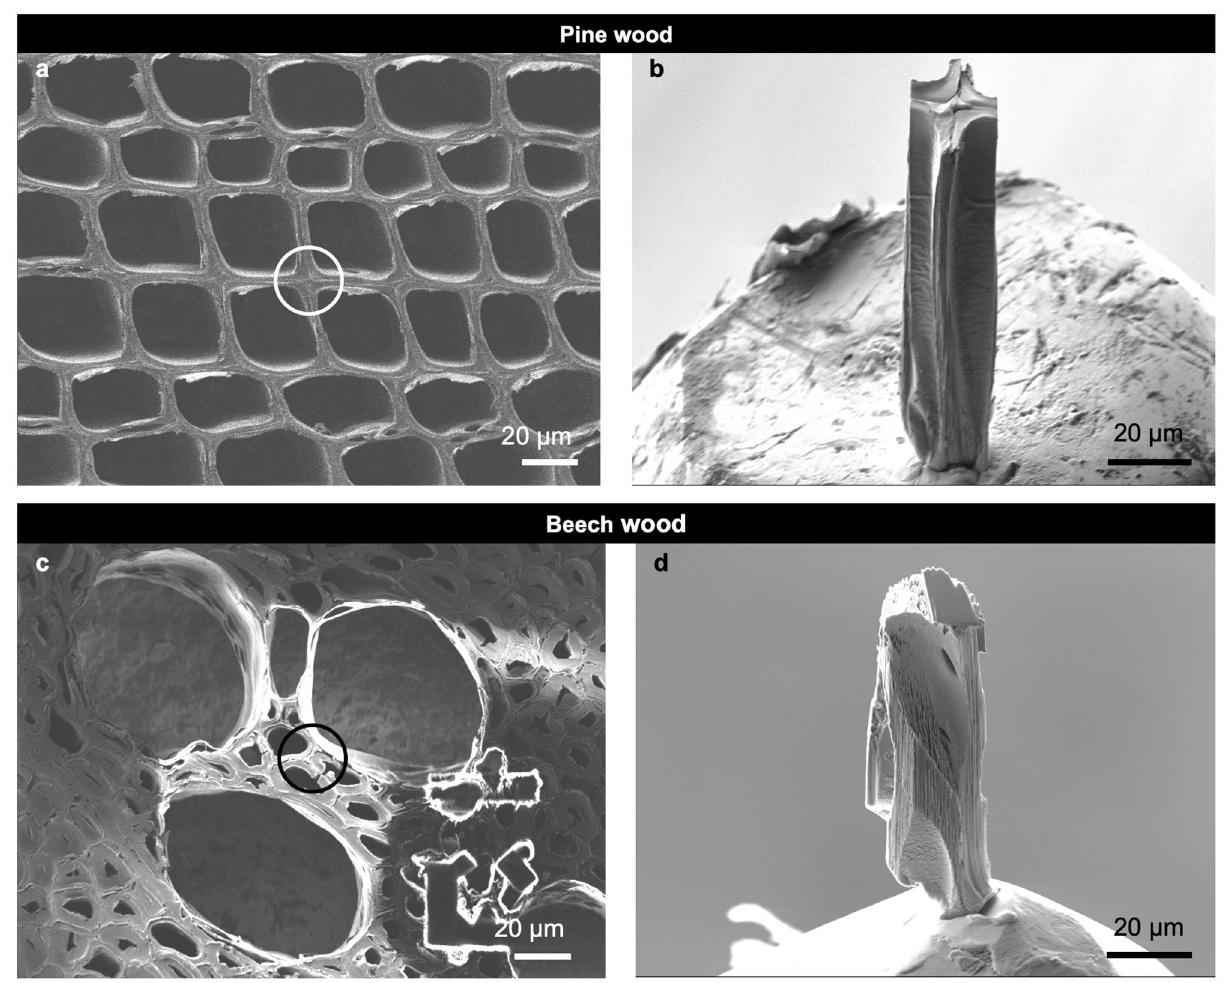
Figure 1. Wood specimens before (left) and after (right) FIB preparation, respectively. The location of the prepared specimens ( b , d ) within the wood tissue is highlighted by circles in ( a ) and ( c ). ( a , b ) Pine earlywood. ( c , d ) Beech earlywood. Scale bars: 20 µm.